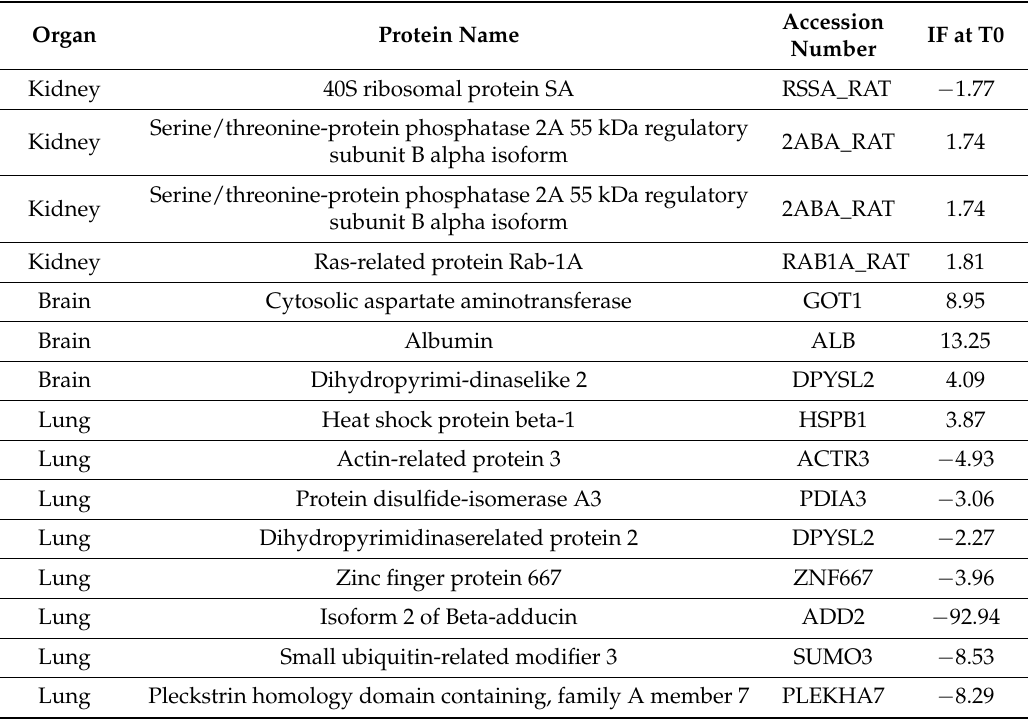
Table 3. Significantly regulated proteins immediately after hyperoxia (T0) in different organs. Positive values express up-regulation ( n = 7), negative values down-regulation ( n = 8).